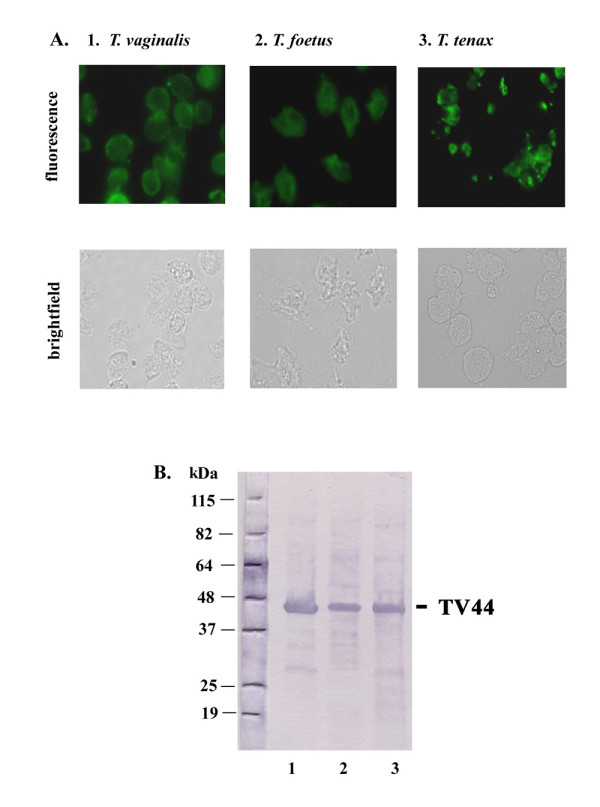
T. vaginalis surface immunofluorescence by monoclonal antibody (mAb) 6B8 and immunoblot detection of a trichomonad protein. A. Fluoresceine isothiocyanate- conjugated goat anti-IgA antibody reacts with the surface of non-permeabilized T. vaginalis (A1), T. foetus (A2), and T. tenax (A3) incubated with IgA mAb 6B8. Brightfield microscopy is provided below the fluorescence panels to illustrate the integrity of the organisms. Fluorescence experiments were performed at least 5 times, and the distinct patchy pattern of fluorescence for T. tenax contrasted with the similar overall surface fluorescence for T. vaginalis and T. foetus. B. Total proteins of 107 trichomonads of T. vaginalis (lane 1), T. foetus (lane 2), and T. tenax (lane 3) were separated on 10% polyacrylamide gels by SDS-PAGE prior to blotting onto Hybond-P™ membranes. Blots were probed with mAb 6B8. Molecular weight of the protein is indicated in kilodaltons (kDa) (×1000).